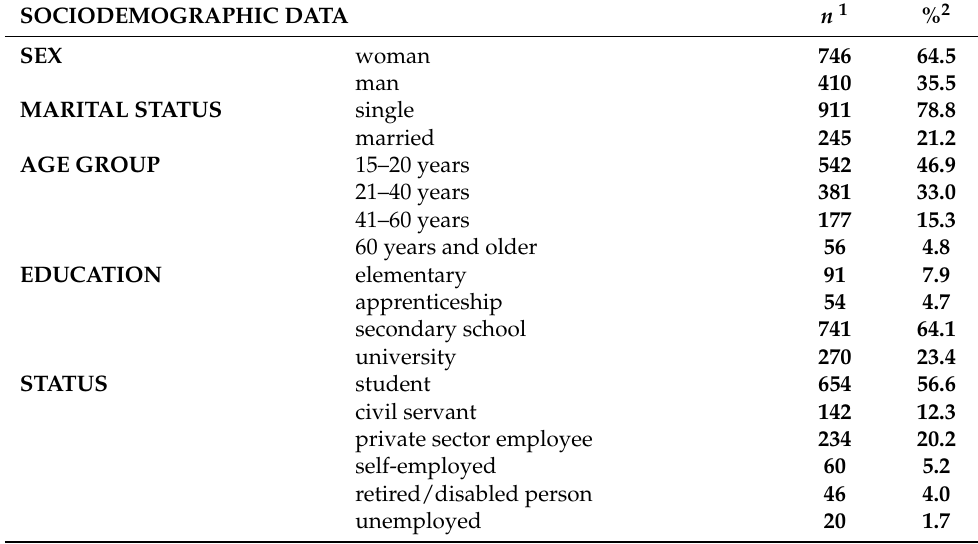
Table 1. Respondents’ socio-demographic